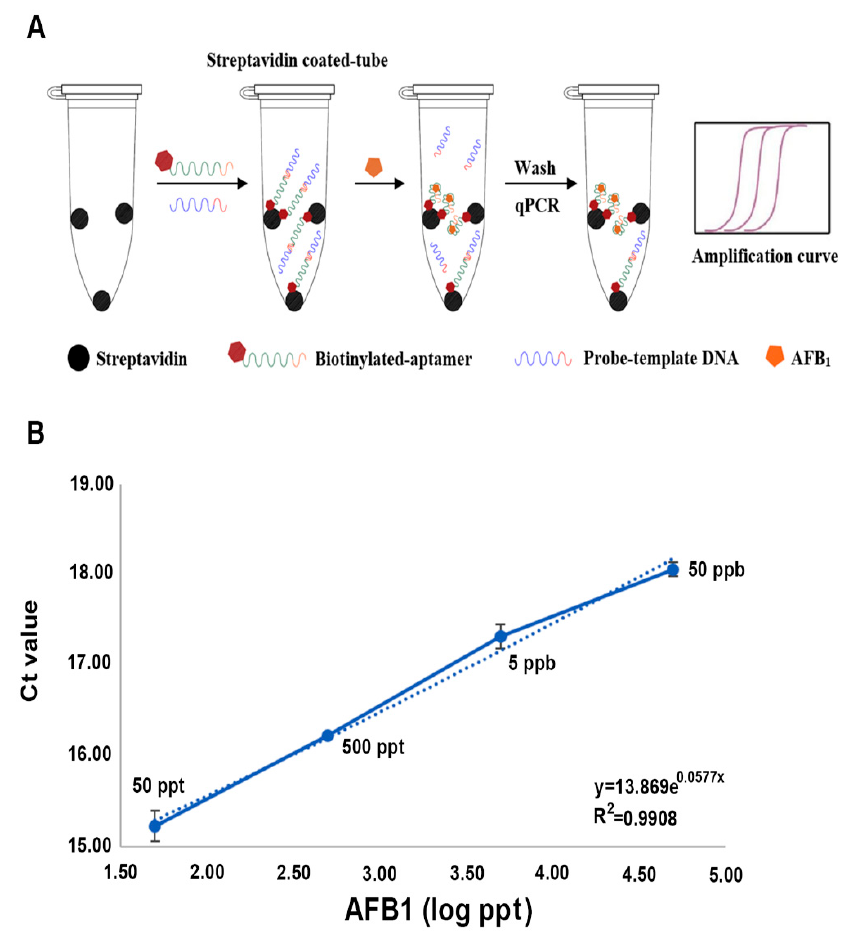
Figure 6. The competitive AFB1 aptasensor system. ( A ) Schematic illustration of the working system of the aptasensor. ( B ) Dynamic range of real-time PCR in determining the amount of AFB1. Table 2. Detection of AFB1 in the spiked